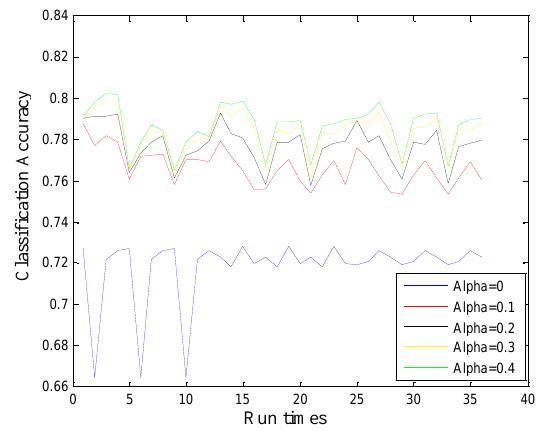
Figure 4 the impact of or Classes 4 and 5 of KSC